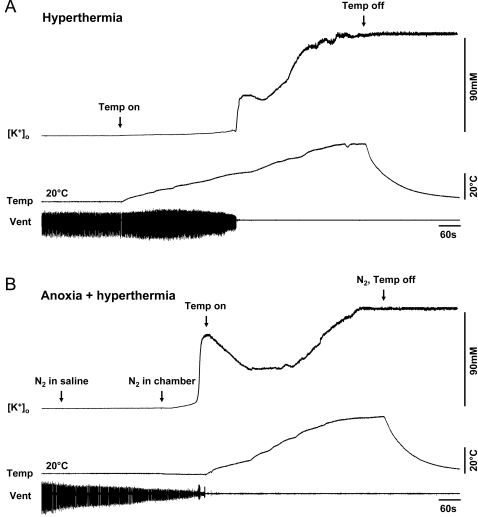
The hyperthermic [K+]o event is not representative of complete collapse of the K+ gradient.A. During a continuous increase of temperature [K+]o increased sharply at ∼40°C coincident with motor pattern failure and continued to rise until a second plateau was reached at ∼60°C. When the heater was turned off [K+]o remained elevated and motor pattern generation failed to recover (N = 11). B. Only the second plateau was evident during temperature increase to ∼60°C following prior anoxic arrest of motor pattern generation. When the N2 was turned off and internal temperature returned to room temperature [K+]o remained elevated and motor pattern generation failed to recover (N = 12).